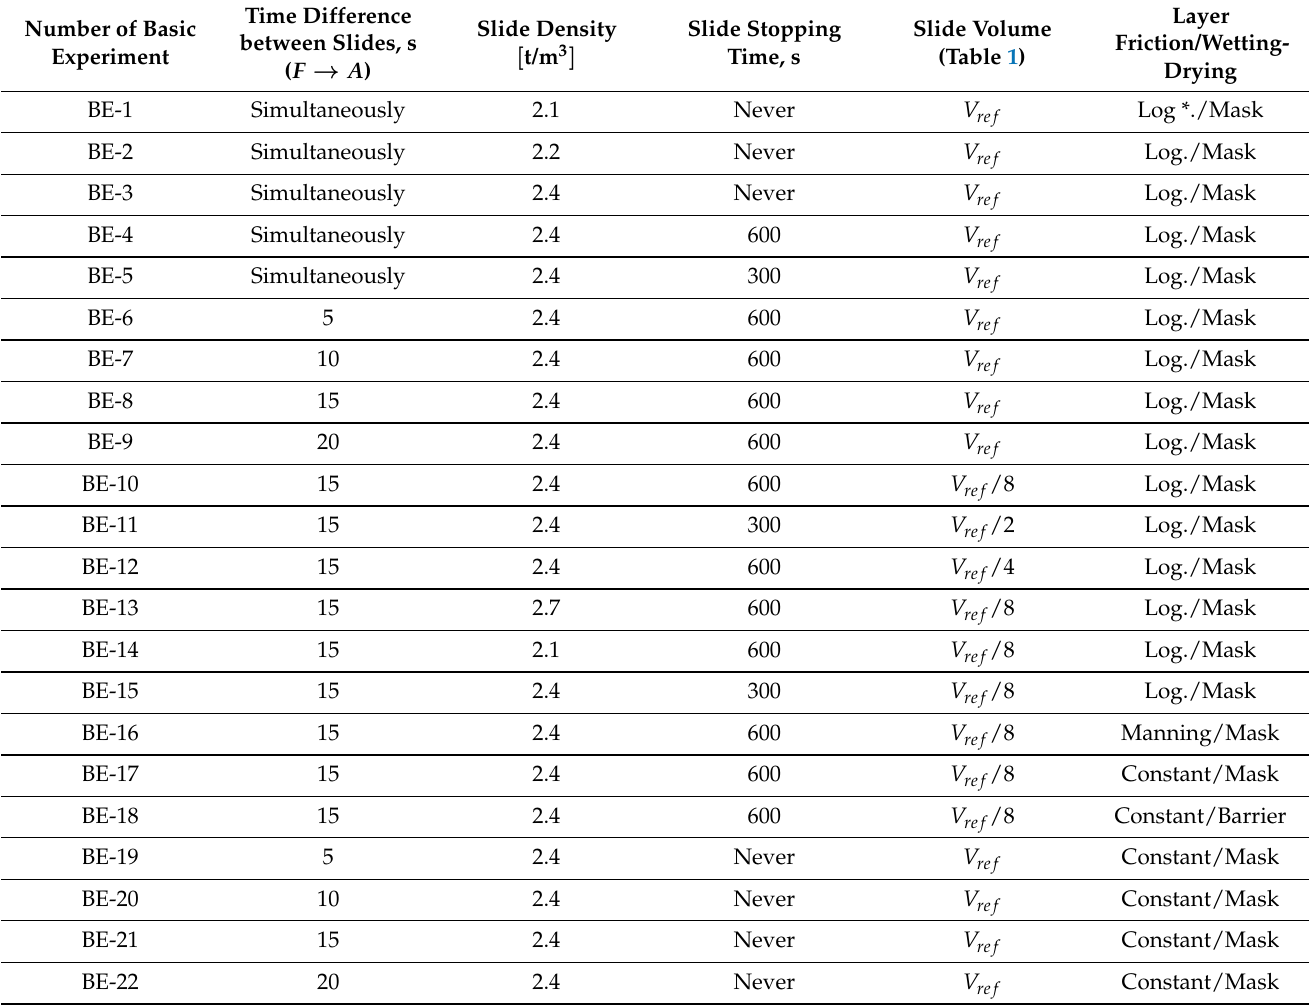
Table 2. Characteristic quantities of the basic experiments